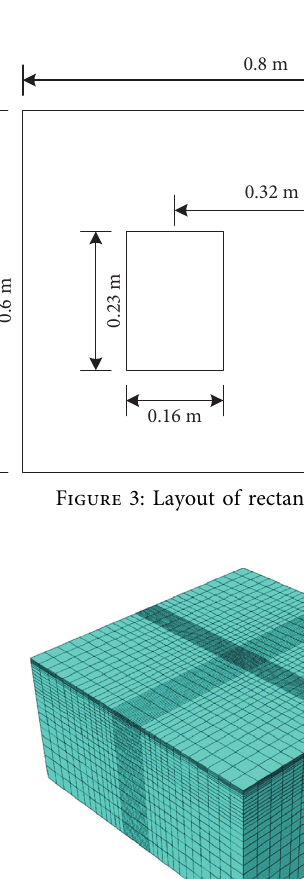
Figure 2: Combination types of pavement structures. (a) Type 1. (b) Type 2. (c) Type 3. (d) Type 4.